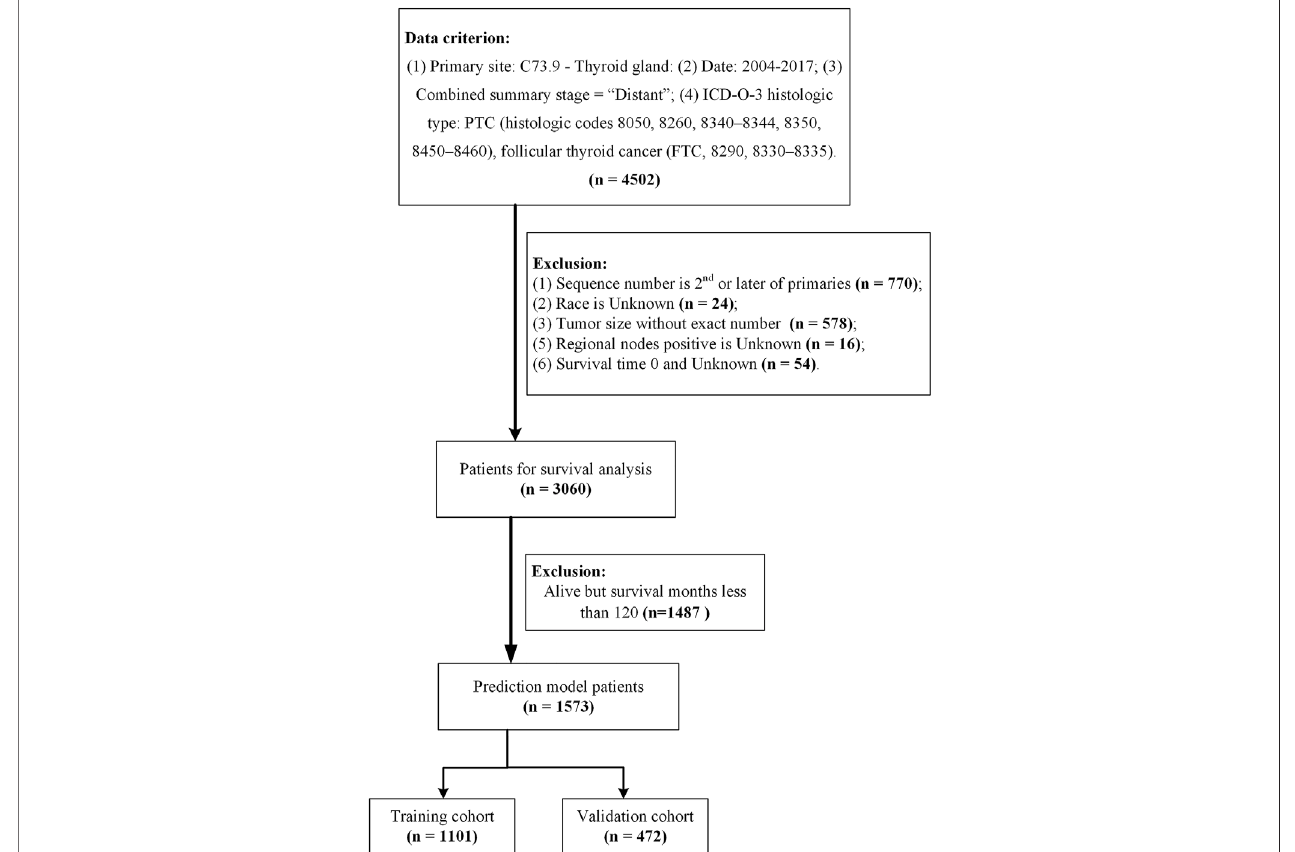
FIGURE 1 | Sample screening